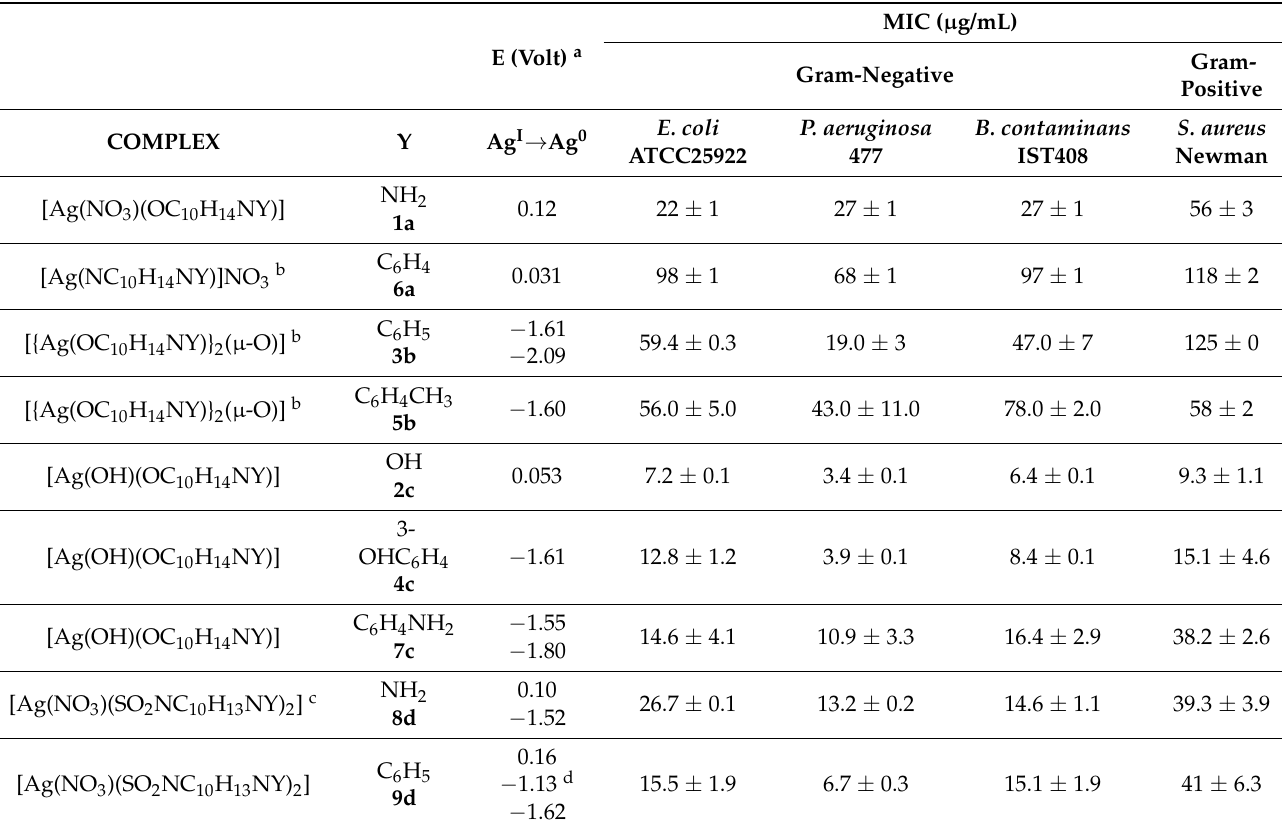
Table 1. Minimum inhibitory concentration (MIC) values and Ag I → Ag 0 reduction potential for complexes.